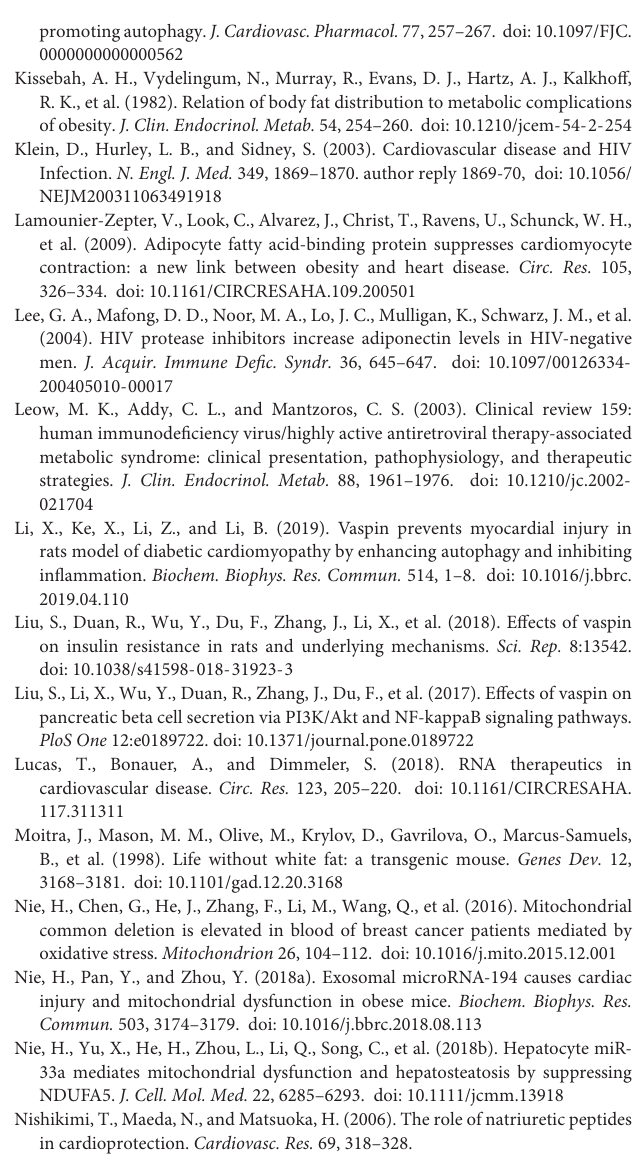
after fat transplantation for 8-week ( n = 5 mice/group). (E,F) The efficiency of injected lentivirus on adipose vaspin expression. Analysis of gene (E) and protein (F) levels of vaspin in transplanted fat ( n = 5 mice/group). Results are showed as mean ± SEM. Supplementary Figure 4 | Blockage of vaspin increased cardiac inflammation, oxidative stress and lipid deposits in A-ZIP/F-1 lipoatrophic mice transplanted with fat. 16-week A-ZIP/F-1 mice were subcutaneously transplanted with 0.9 g visceral fat from C57BL/6J mice, and tail-veil injected with 1 10 9 lentivirus encoding vaspin siRNA or control siRNA for 8 weeks. The cardiac levels of triglyceride (A) , free fatty acid (B) , TNF- α (C) , IL-1 β (D) , and NO (E) . Results are showed as mean ± SEM, and n = 7 mice/group. ∗ p < 0.05, ∗∗ p < 0.01, ∗∗∗ p < 0.001. Supplementary Figure 5 | The changes of cardiac AKT activity in A-ZIP/F-1 lipoatrophy mice. (A) Western blot analysis of cardiac levels of phosphorylated AKT and total AKT in 4-, 12-, and 24-week old A-ZIP/F-1 mice and C57BL/6J (C57) mice. (B) Quantitative analysis of relative density. (C) The measurement of cardiac AKT activity by commercial kit. A-ZIP/F-1 mice aged 24-week were